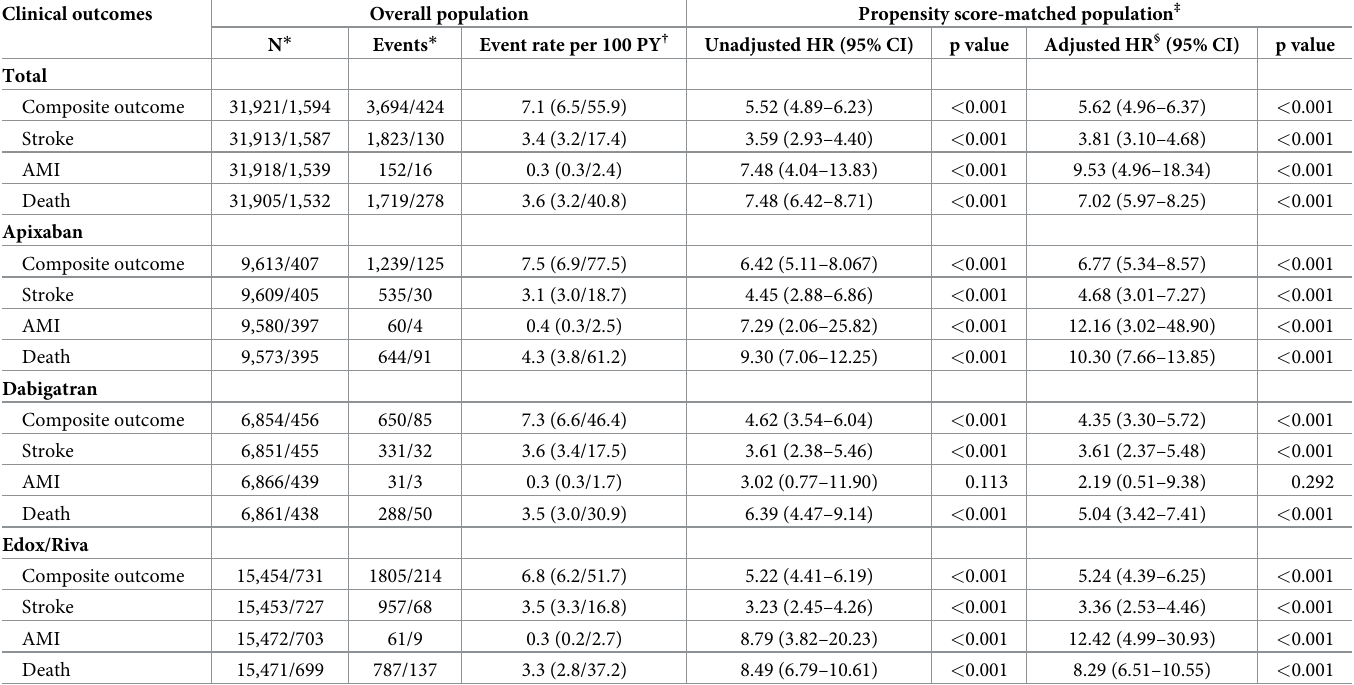
Table 2. Event and event rate in NOAC users in the overall study population and the comparative risks for clinical outcomes of patients with low adherence com- pared with those with high adherence in propensity score-matched